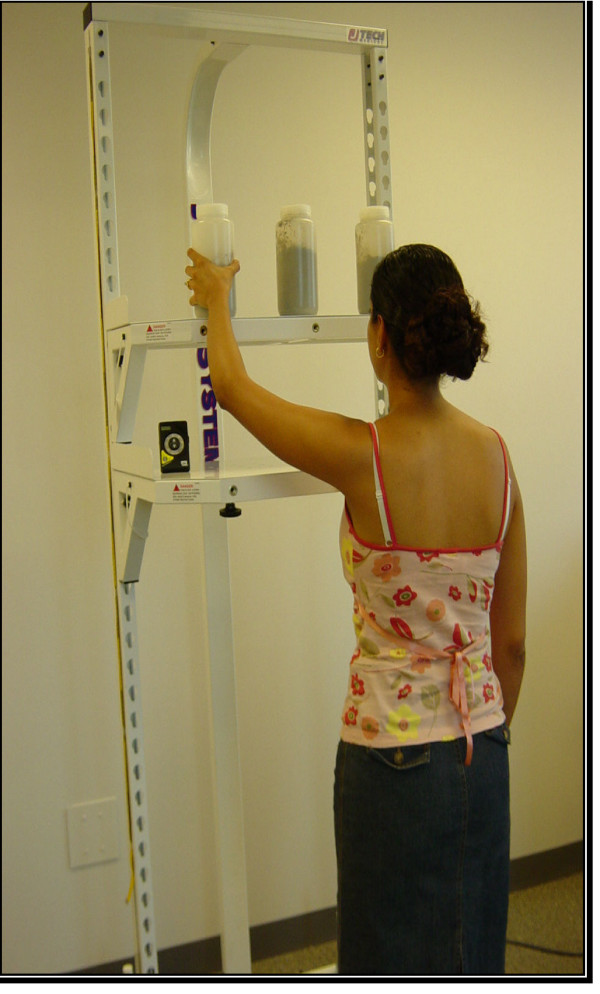
Task 2, "Eye-Down".